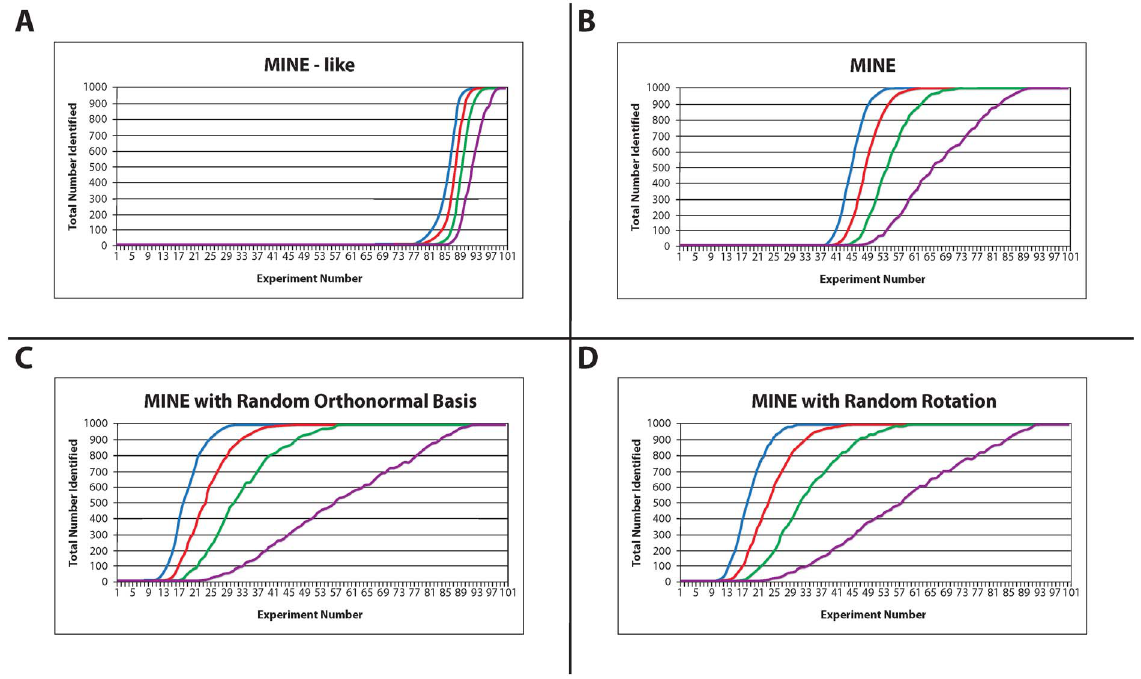
Figure 3. Graph of the number of significant nonzero regression coefficients averaged over 1000 replicates for: (A) the MINE-like method; (B) MINE method; (C) MINE method with random orthonormal basis; (D) MINE method with random rotation. Each graph identifies the number of replicates (y-axis) with a varying number of the nonzero b 0 components as significant as a function of the number of experiments (x-axis). Blue corresponds to 70% correctly identified, red to 80%, green to 90% and purple to 100%.